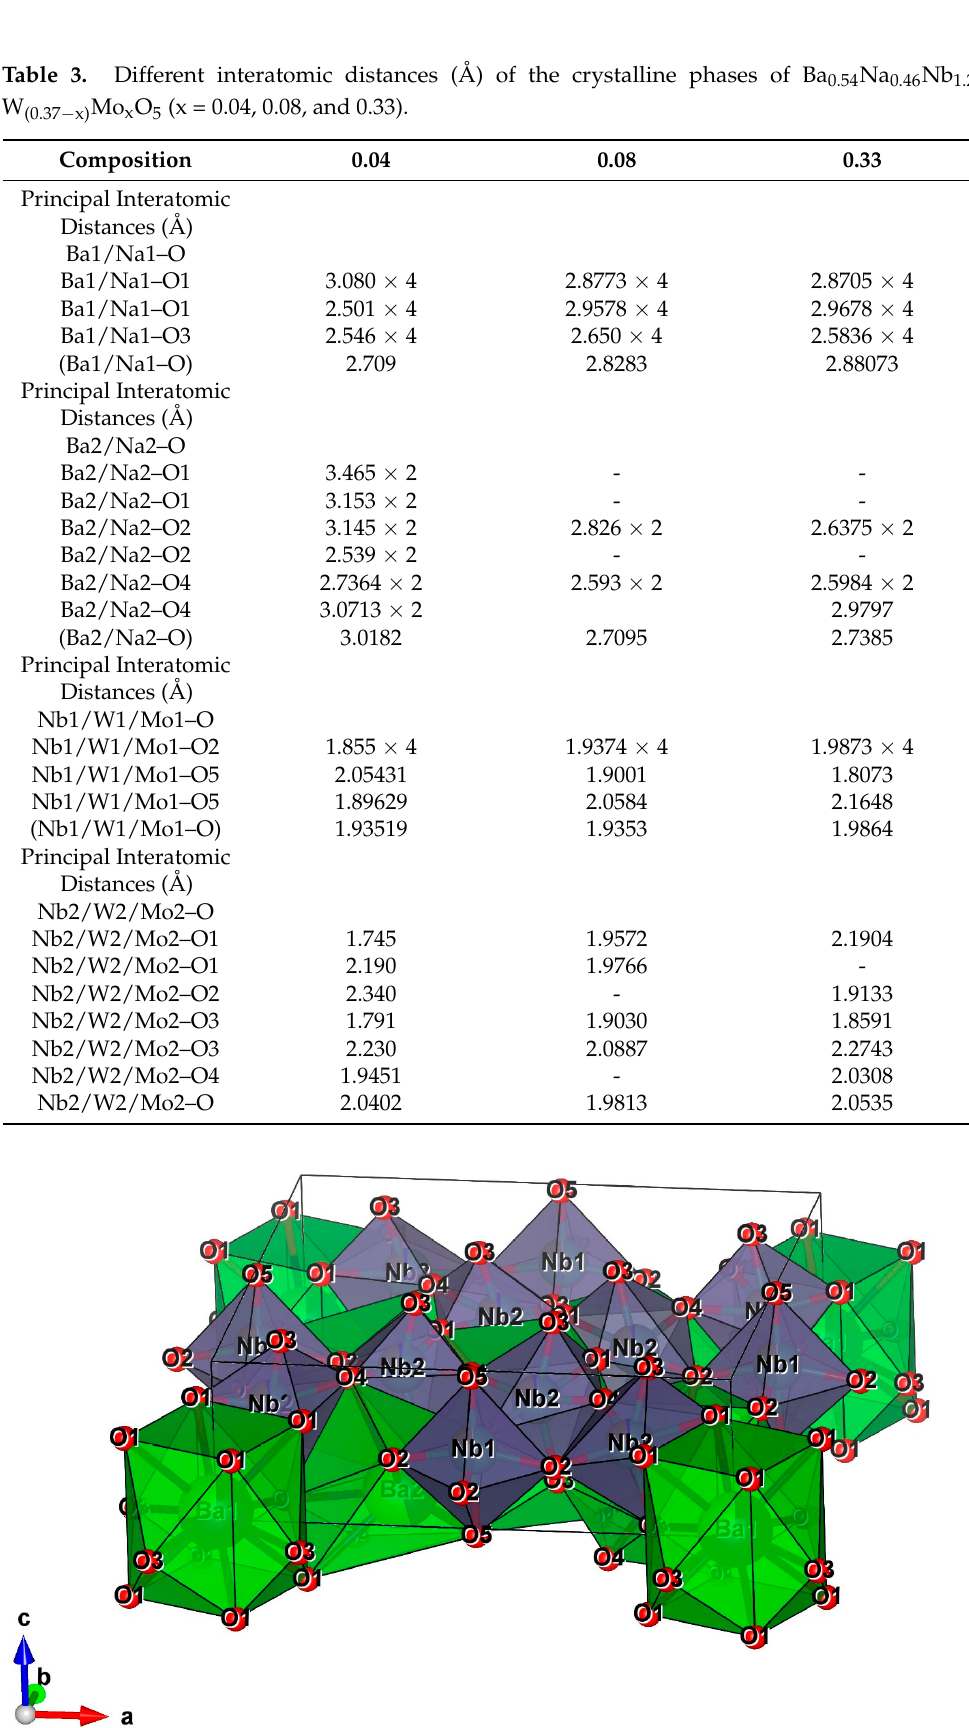
Figure 2. Crystal structure where x = 0.33, projected in 3D space ([1 1 1]).